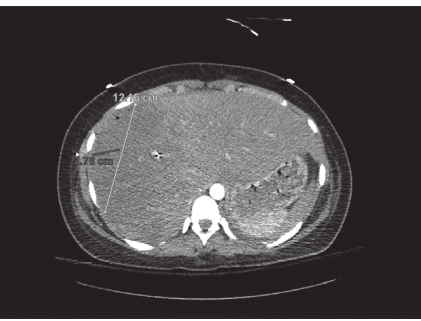
Figure 2: CTA abdomen on postoperative day 4 showing im- provement in size and no active arterial